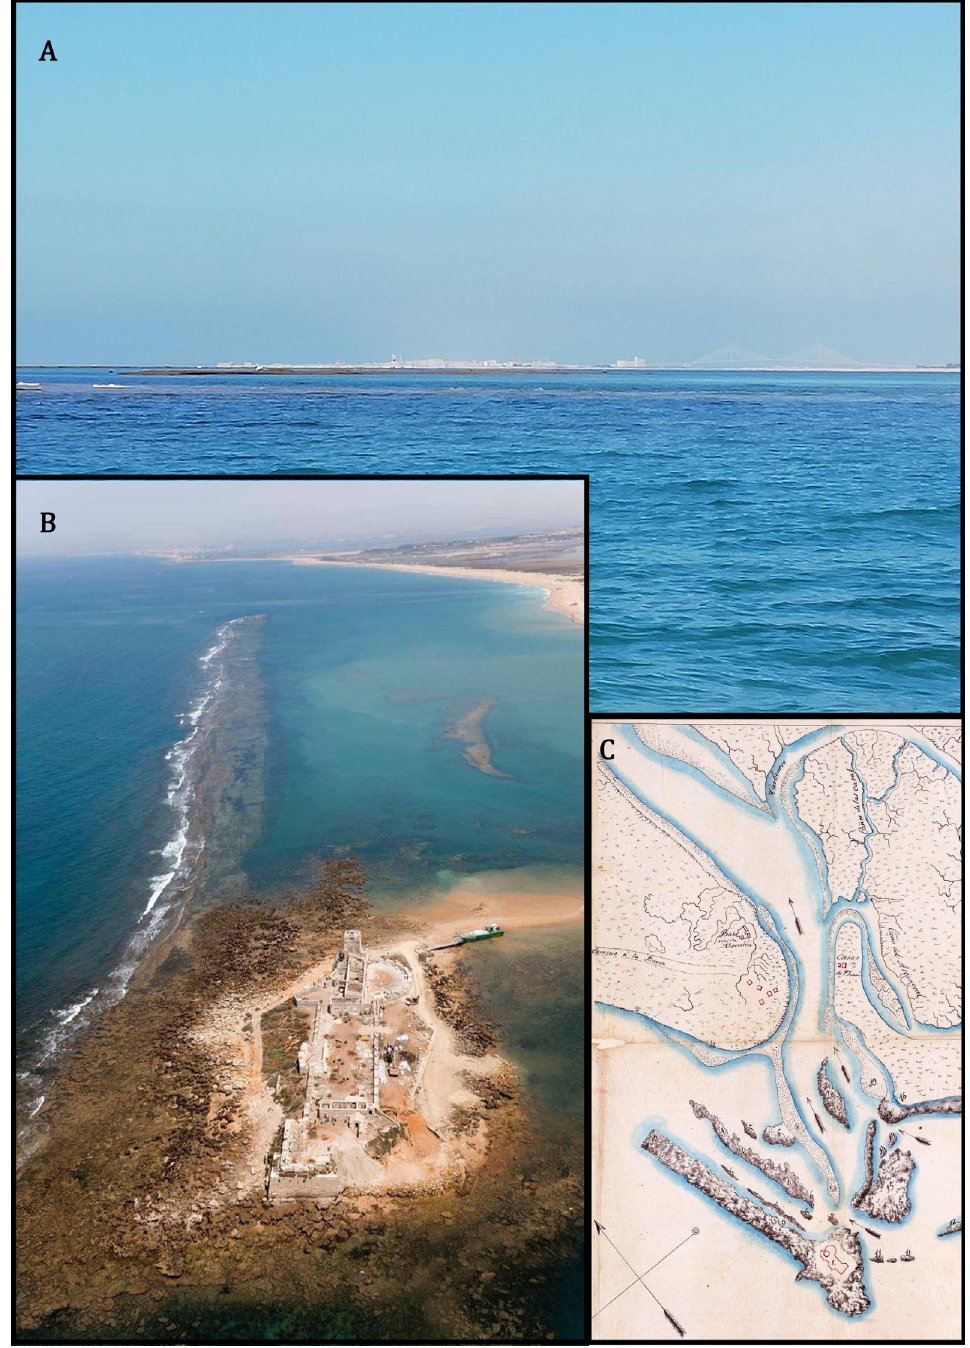
Figure 13. A-B. Visual projection from Sancti Petri Castle towards the N. ©Authors. C. Historical map of the Islet of Sancti Petri. Comandancia de Ingenieros ©Archivo Histórico Provincial de